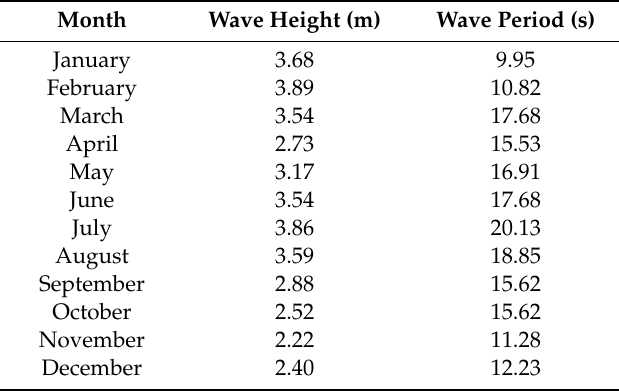
Table 5. Wave Height and Wave Period.